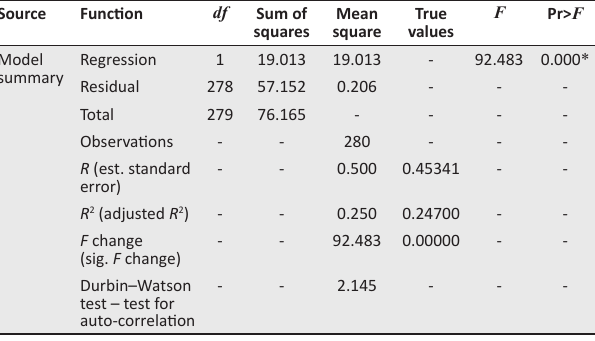
TABLE 11: Simple linear regression model fit and summary for knowledge sharing on small and medium enterprises’ innovation capabilities. Source Function df